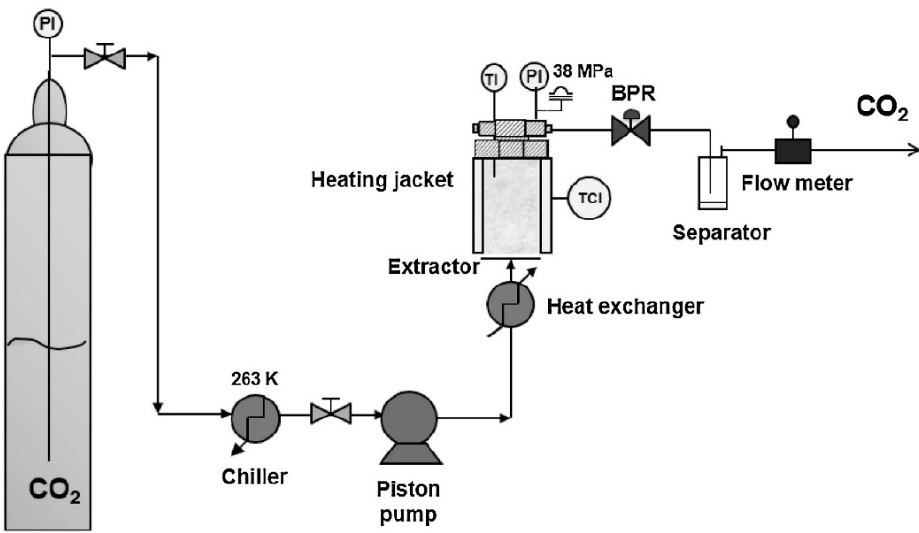
Figure 6. Scheme of the equipment used for supercritical fluid extraction of emulsions (SFEE). Reprinted with permission from Ref. [39]. Copyright 2016, Elsevier.